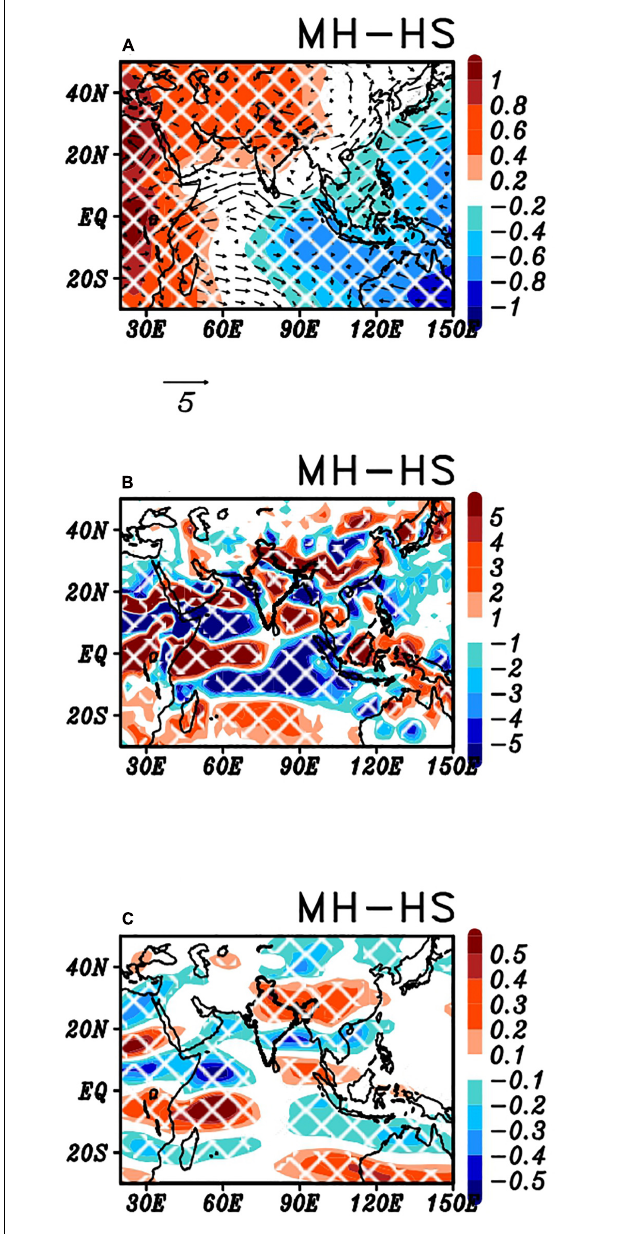
FIGURE 5 | (A) Spatial distribution of the simulated 850 hPa differences in the time-averaged JJAS velocity potential “ χ 850” (m 2 s − 1 ; Shaded), and overlaid by the mean monsoon winds (m/s; Vectors) for MH period relative to that for the HS. (B) Show spatial distributions of simulated 600 hPa differences in the time-averaged JJAS Moisture Flux Convergence [10 − 5 g/(kg − s )]. (C) Shows spatial distributions of simulated 500 hPa relative vorticity ( × 10 − 5 S − 1 ) for the MH period relative to that for the HS. Hatched region represents a statistically significant region at a 95% confidence level from the two-tailed Student’s t